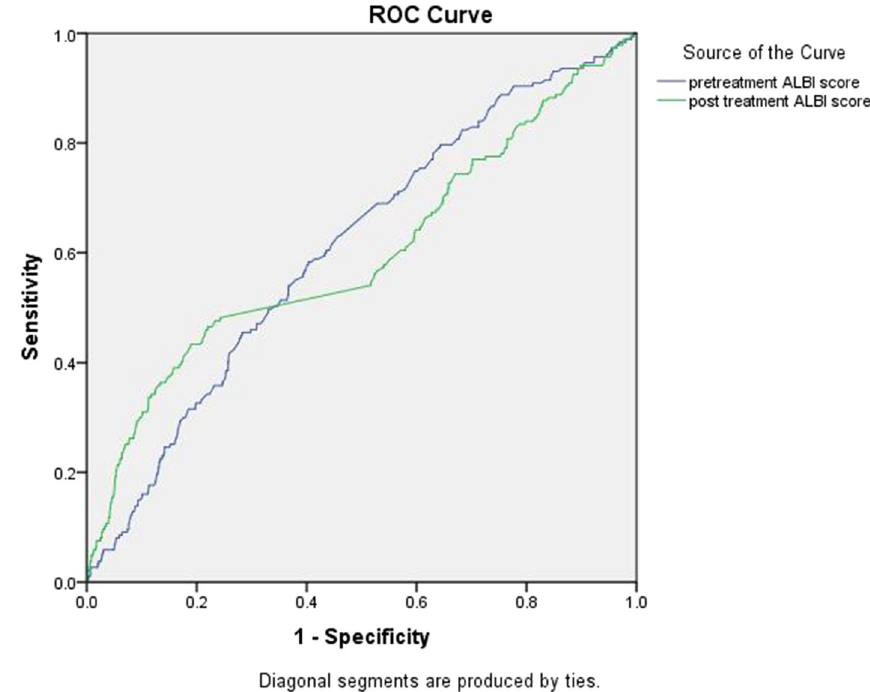
Fig. 3 ROC curve for prediction of hepatic decompensation after DAAs using ALBI